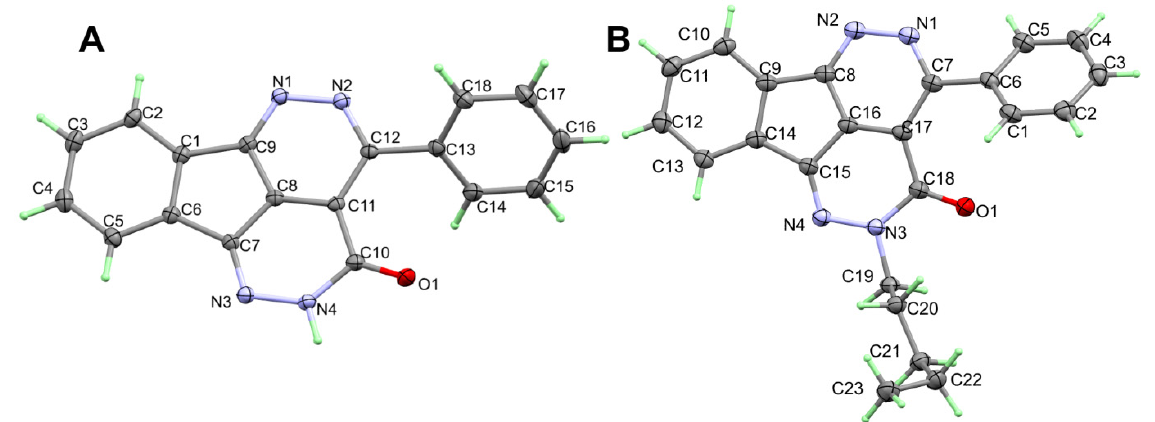
Figure 2. ORTEP of compounds 2 ( A ) and 6 ( B ). Table 1. Crystal data of 2 and 6.